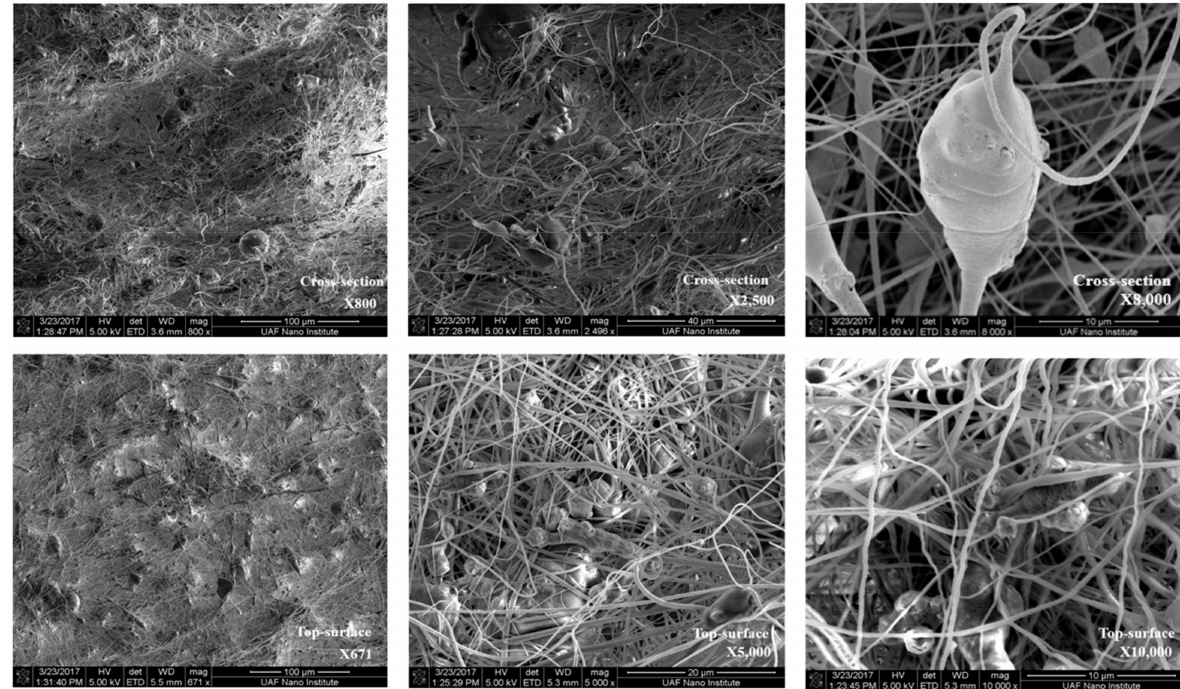
Figure 2. SEM images of cross-sectional surfaces ( top panel) and top surfaces ( bottom panel) of fabricated mixed matrix membrane (20%PES-100%Zeolite13X) with increased left to right